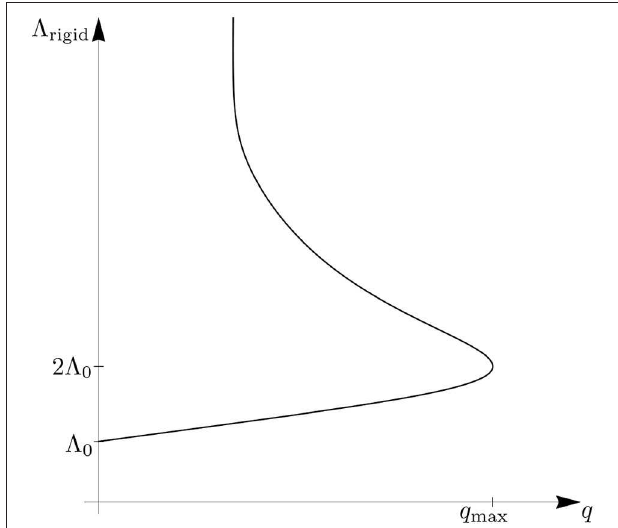
FIGURE 5 | The cosmological constant appearing in the rigid picture’s Ŵ q in dependence on its natural RG scale q . While we are able to